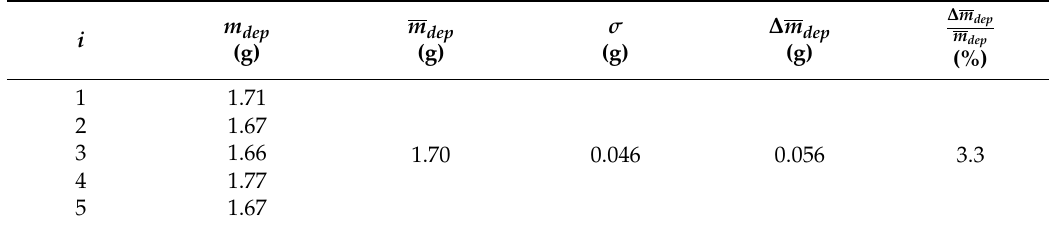
Table 4. Test results of the deposition